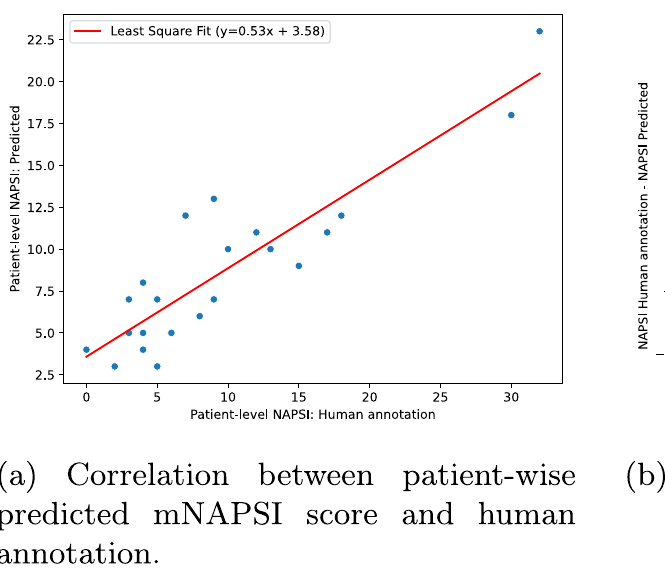
Figure 5. Correlation analysis of the predicted and human-annotated mNAPSI scores on the patient